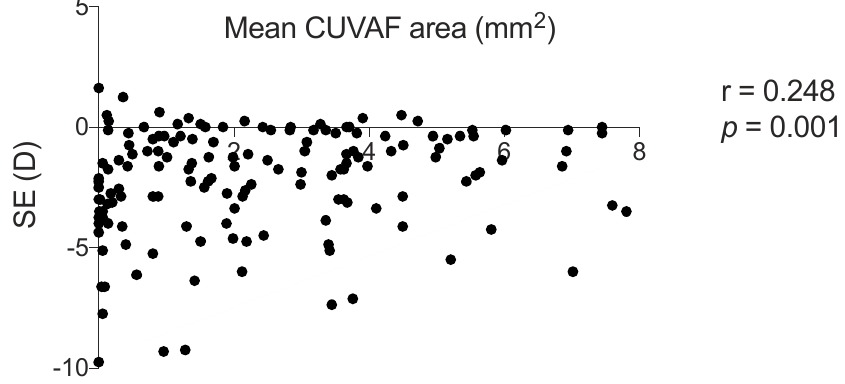
Figure 5. Pearson correlation analysis between spherical equivalent and mean CUVAF area (mm 2 ). CUVAF: conjunctival ultraviolet autofluorescence. D: dioptres. SE: spherical equivalent. Significance p < 0.05.